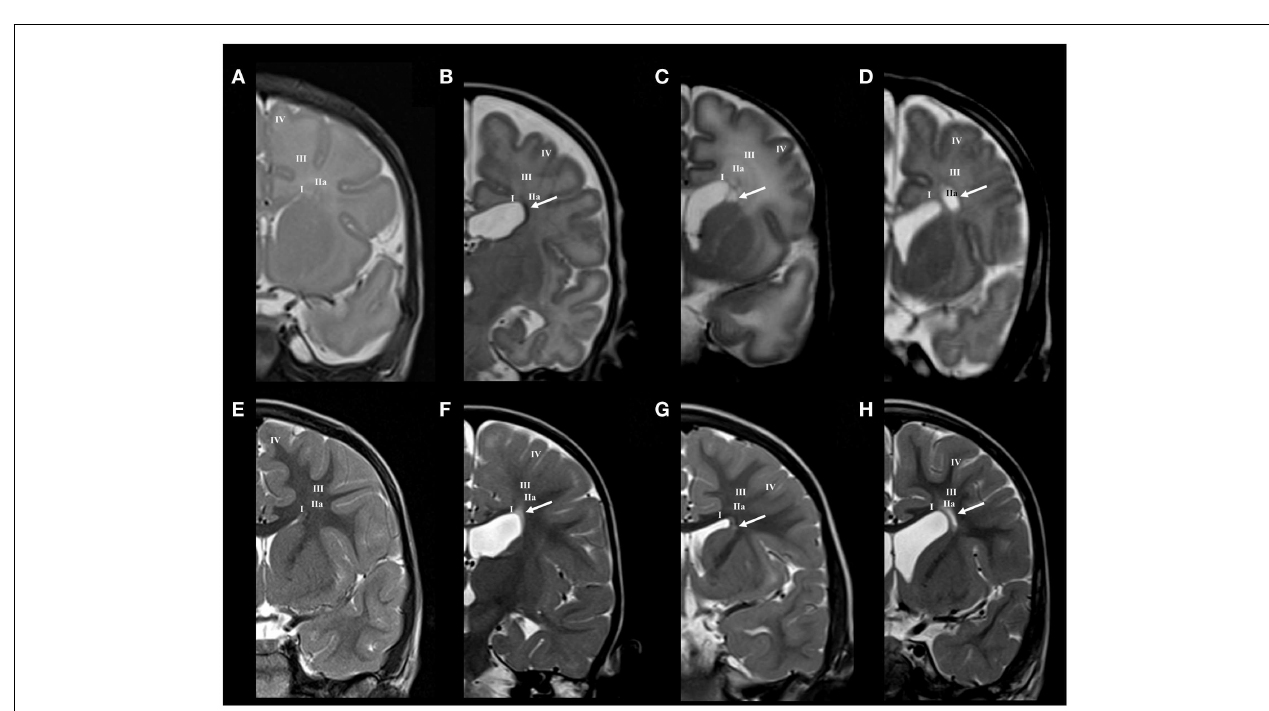
with cystic lesion in area of subcallosal and fronto-occipital fascicle at term equivalent age [arrow in (C) ], which changed to discrete scar within fronto-occipital fascicle at the age of 3years [arrow in (G) ]. Late preterm (born at 31 PCW, BW = 1670g, SNAPII = 8, SNAPPEII = 8, AS = 8/10) with large cystic lesion at the crossroad area at term equivalent age [arrow in (D) ], which appears as smaller cystic lesion at the age of 3years [arrow in (H) ]. Numbers I–IV represent segments of white matter as previously described in